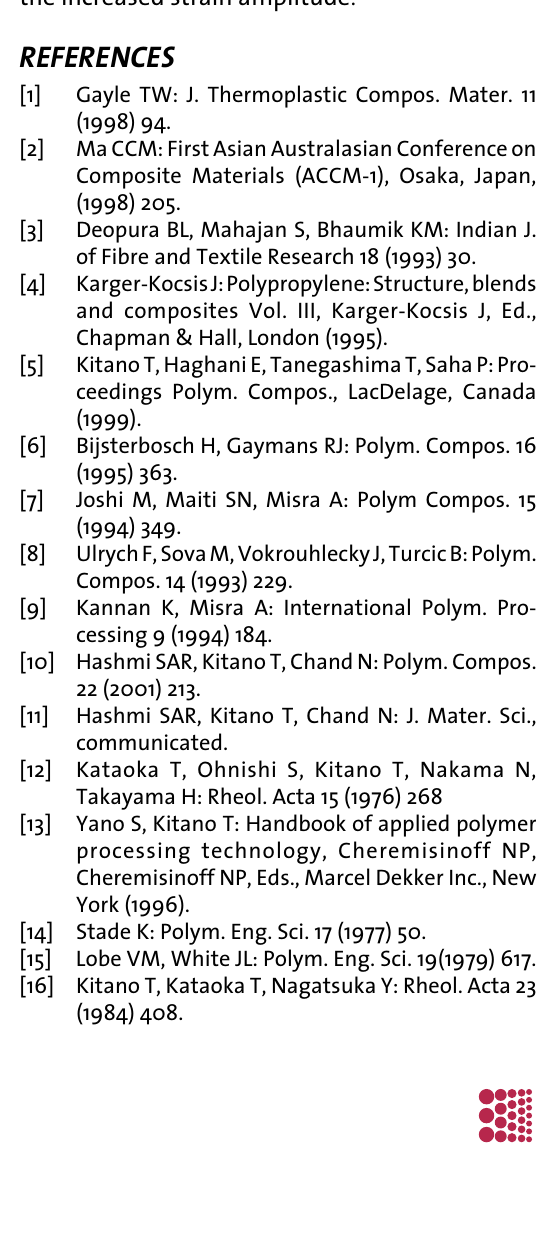
Figure 14 (left): Storage modulus, G’, as a function of strain amplitude, g , for LL - GF/KF (80-50/50) at w = 0.127 s-1. Figure 15 (right): Loss modulus, G’’, as a function of strain amplitude, g , for LL - GF/KF (80-50/50), at w = 0.127